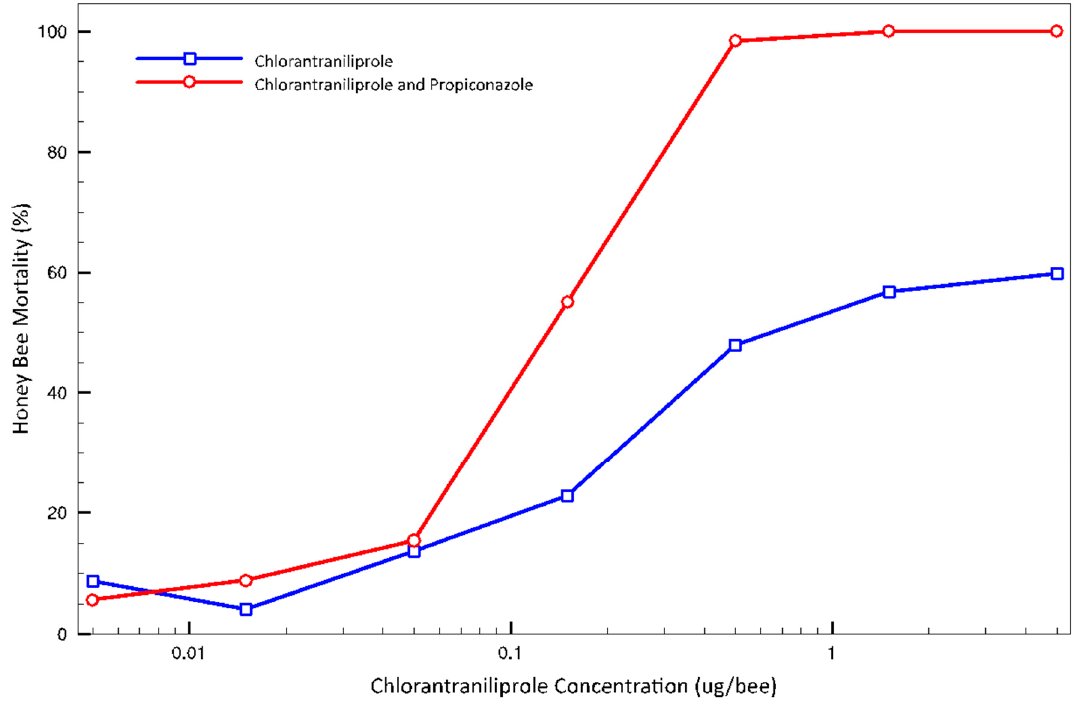
Figure 4. Dose-response curves for topical treatment of adult worker honey bees with chlorantraniliprole (N = 697) or chlorantraniliprole mixed with propiconazole (N = 476) at a 1:2.25 ratio.